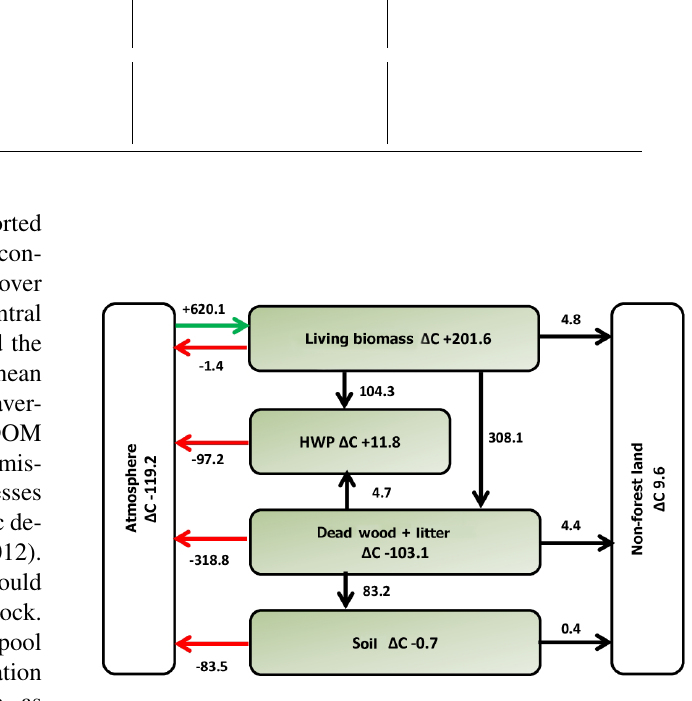
Figure 2. Summary of the average C increment and transfers be- tween forest pools and with the atmosphere and non-forest land for the FM area (in teragrams of carbon per year, for the historical pe- riod 2000–2012). The pool increments are shown in each box as (cid:49) C. Transfers between pools are shown as black arrows and trans- fers from and to the atmosphere are shown as green and red arrows, respectively (with positive or negative values, reported from a forest perspective). Further details are reported in Fig.